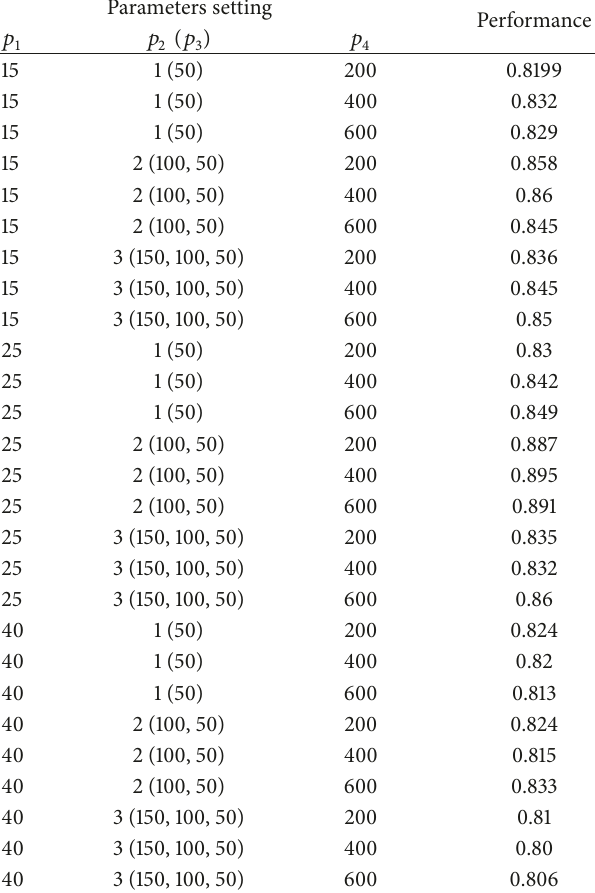
Table 3: Performance with different parameters.